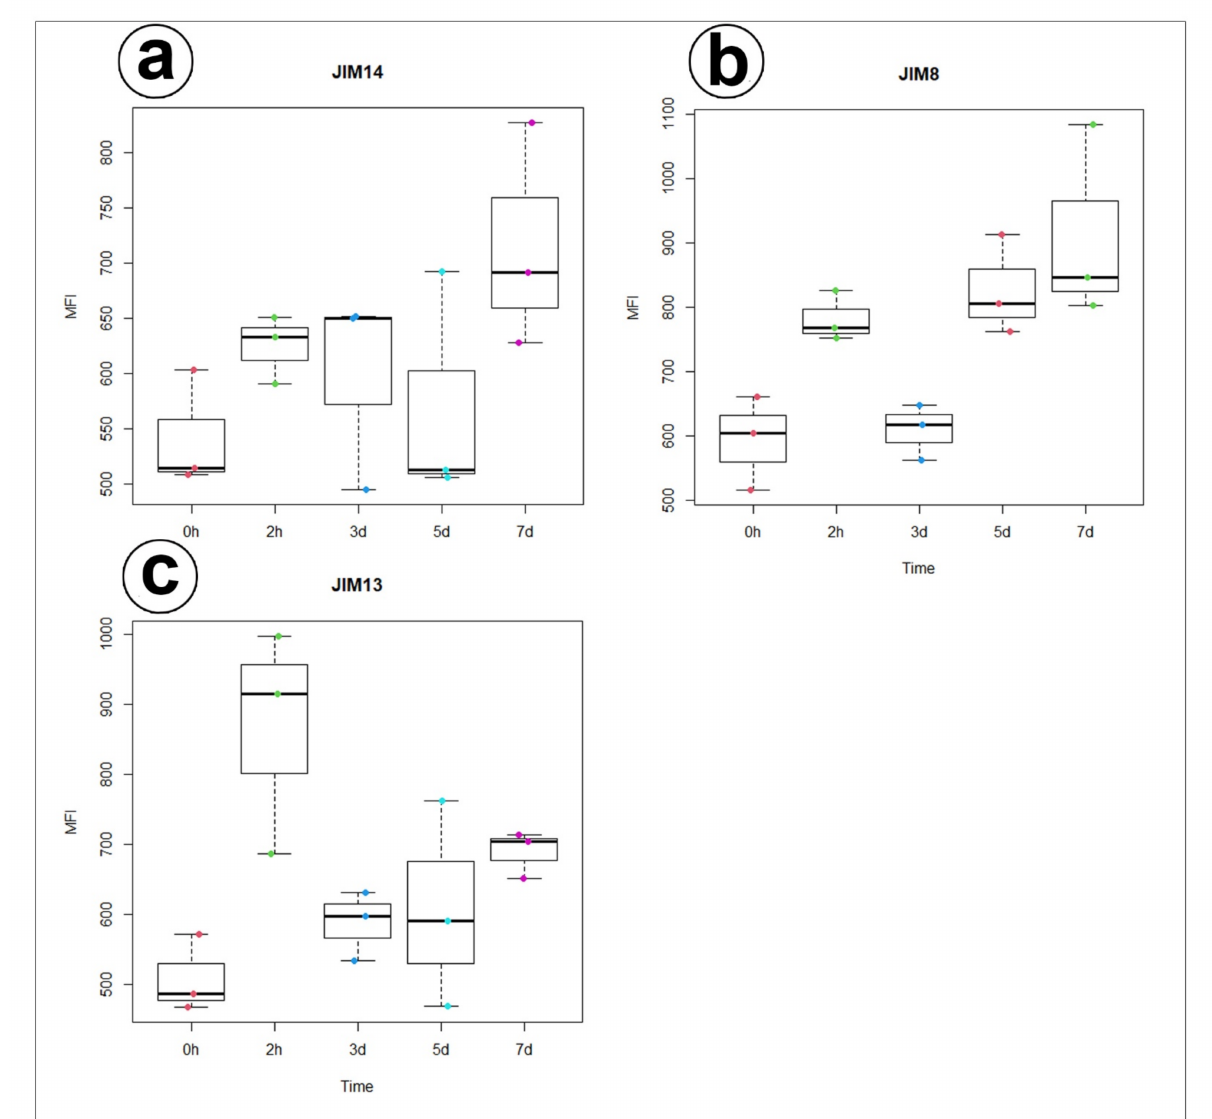
Figure 6. Quantification of immunofluorescence labelling. Mean value of AGP fluorescence intensity (MFI) labelled by ( a ) JIM14, ( b ) JIM8, and ( c ) JIM13 antibodies in 3 secretory cells from 3 different glands (n = 3) during 0 and 2 h, 3, 5, and 7 days after feeding